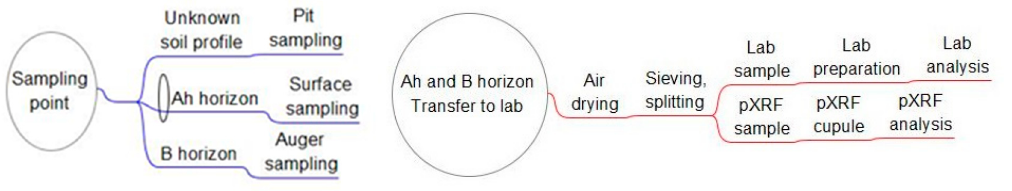
Figure 2. Map of sample locations on geological background map [26]. ( A ): La Télachère; ( B ): Les Brouzils; ( C ): La Copechagnière.